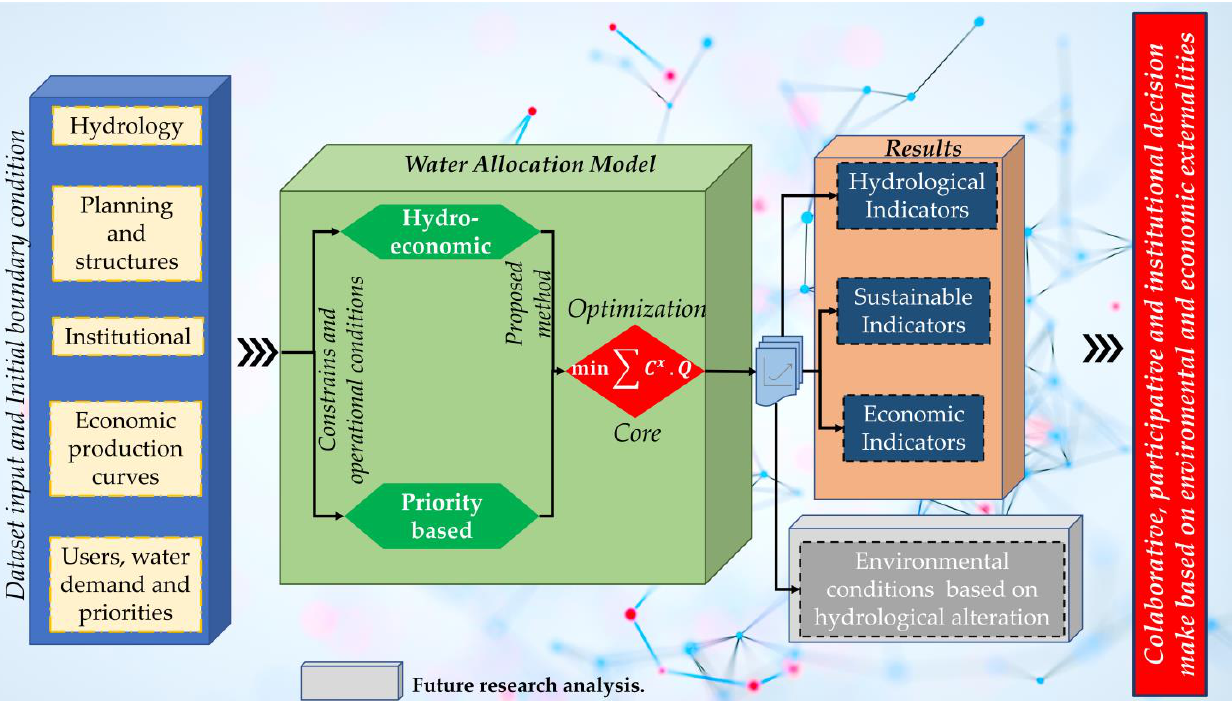
Figure 2. The proposed AcquaNetGIS water allocation model.